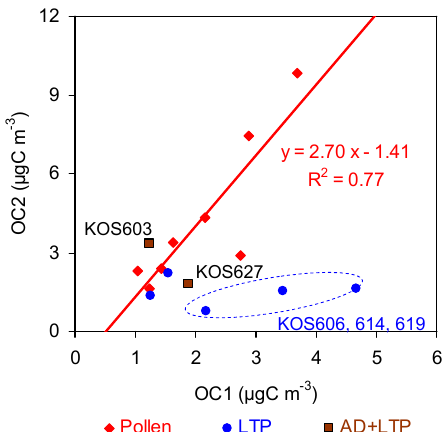
Fig. 11. Thermograms of carbonaceous particles during the (a) AD+LTP, (b) pollen, (c) LTP (KOS606, 614, and 619), and (d) LTP (KOS621 and KOS623) episodes. The analytical errors of OC and EC measurements were 5% and 3%, respectively. Base line of each thermogram was shifted 0.5 toward the y-axis to better visual- ization of overlaying thermograms.